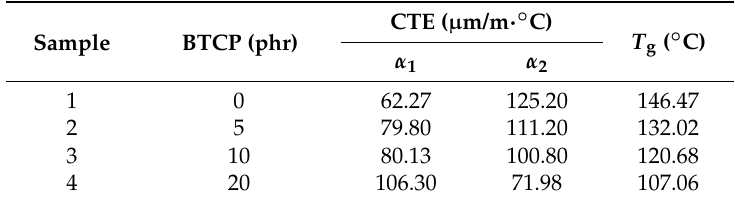
Table 4. TMA data for each epoxy composition with varying amounts of